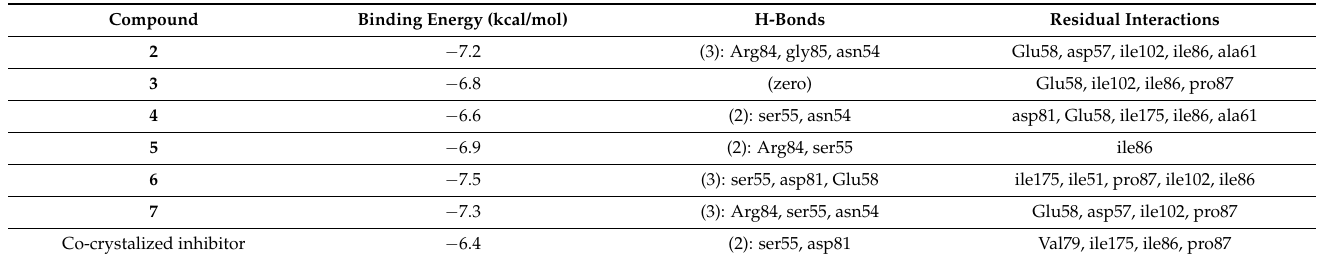
Table 4. Interactions of the docked compounds with bacterial DNA gyrase